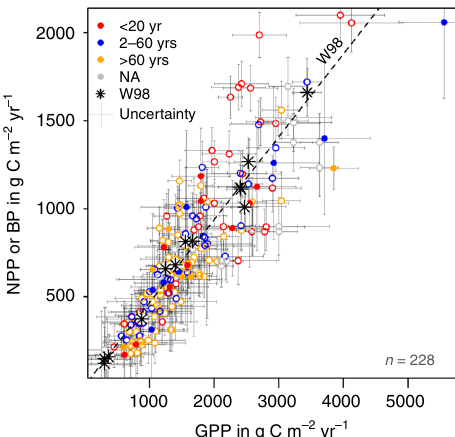
Fig. 3 Comparison of the present work dataset vs. Waring et al. 6 . Scatter plot of net primary production (NPP, gC m − 2 yr − 1 ) or biomass production (BP, gC m − 2 yr − 1 ) versus gross primary production (GPP, gC m − 2 yr − 1 ) ( n = 228). Open circles: BP, fi lled circles: NPP. Stars represent data points from Waring et al. 6 . The line marked with W98 represents a CUE (i.e. NPP/ GPP) of 0.47. Age classes are marked by colours (see top left of the fi gure); NA stands for ‘ age not available ’ . The uncertainty (gC m − 2 yr − 1 ) of the data points is indicated by bars (for data uncertainty see